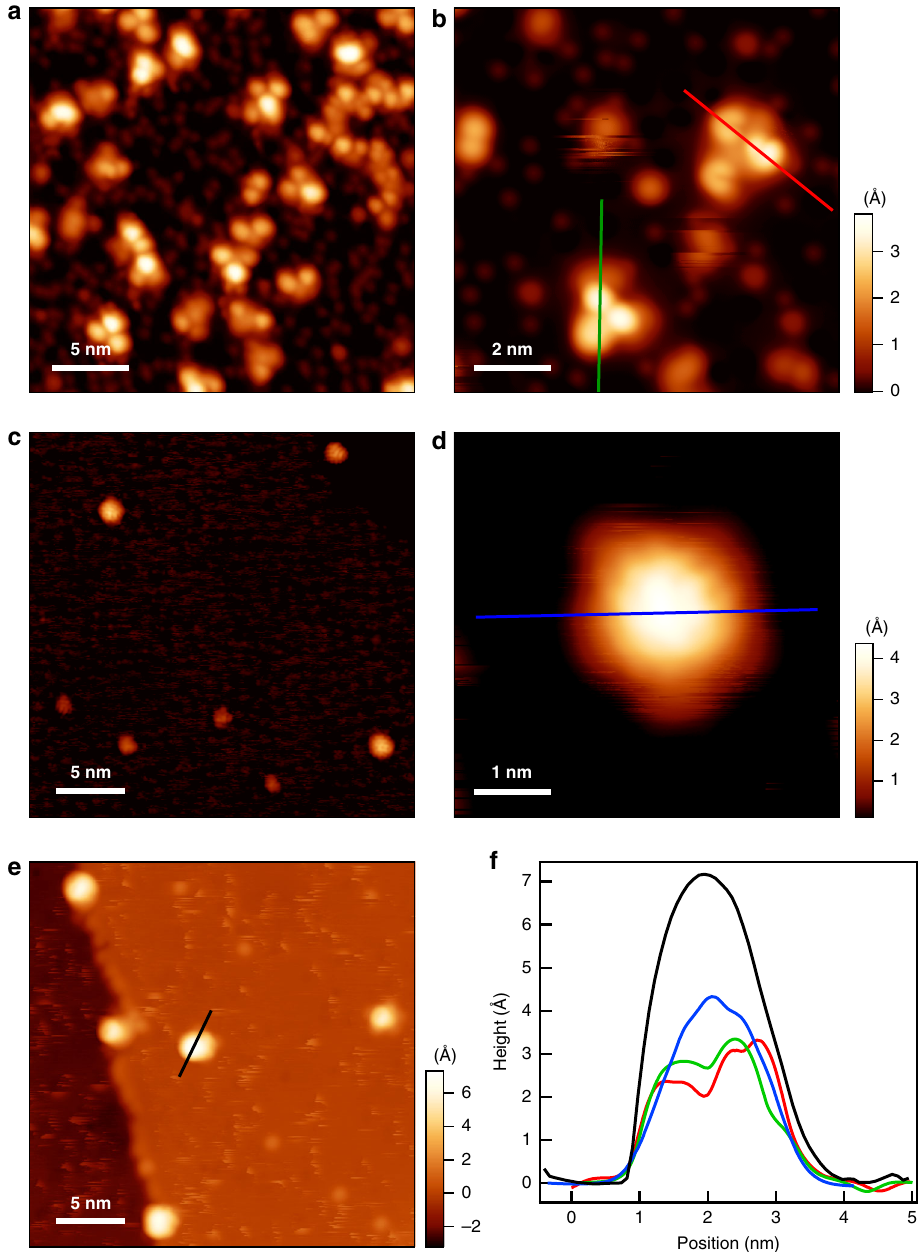
Fig. 7 STM images of the formation of (7,5) SWCNT seeds from the AAB precursor. a , b Precursor molecules as deposited on Pt(111) held at room temperature. Molecules deposited on hot Pt(111) ( c , d , held at 470 K), and after continuous annealing for 10 min at 470 K ( e ). f Line pro fi les (positions indicated in (b , d , e ) over as-deposited precursors (red and green lines), closing cap (blue line), and a fi nished SWCNT seed (black line). STM setpoints are − 0.4 V, 10pA ( a ), 1 V, 50pA ( b ), 1.5 V, 50pA ( c ), − 3V, 100pA ( d ), and − 2.5 V, 100pA ( e